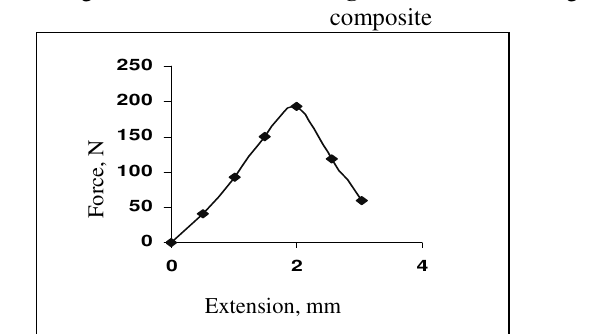
Figure 10. Tensile strength of SF- Rnf composite